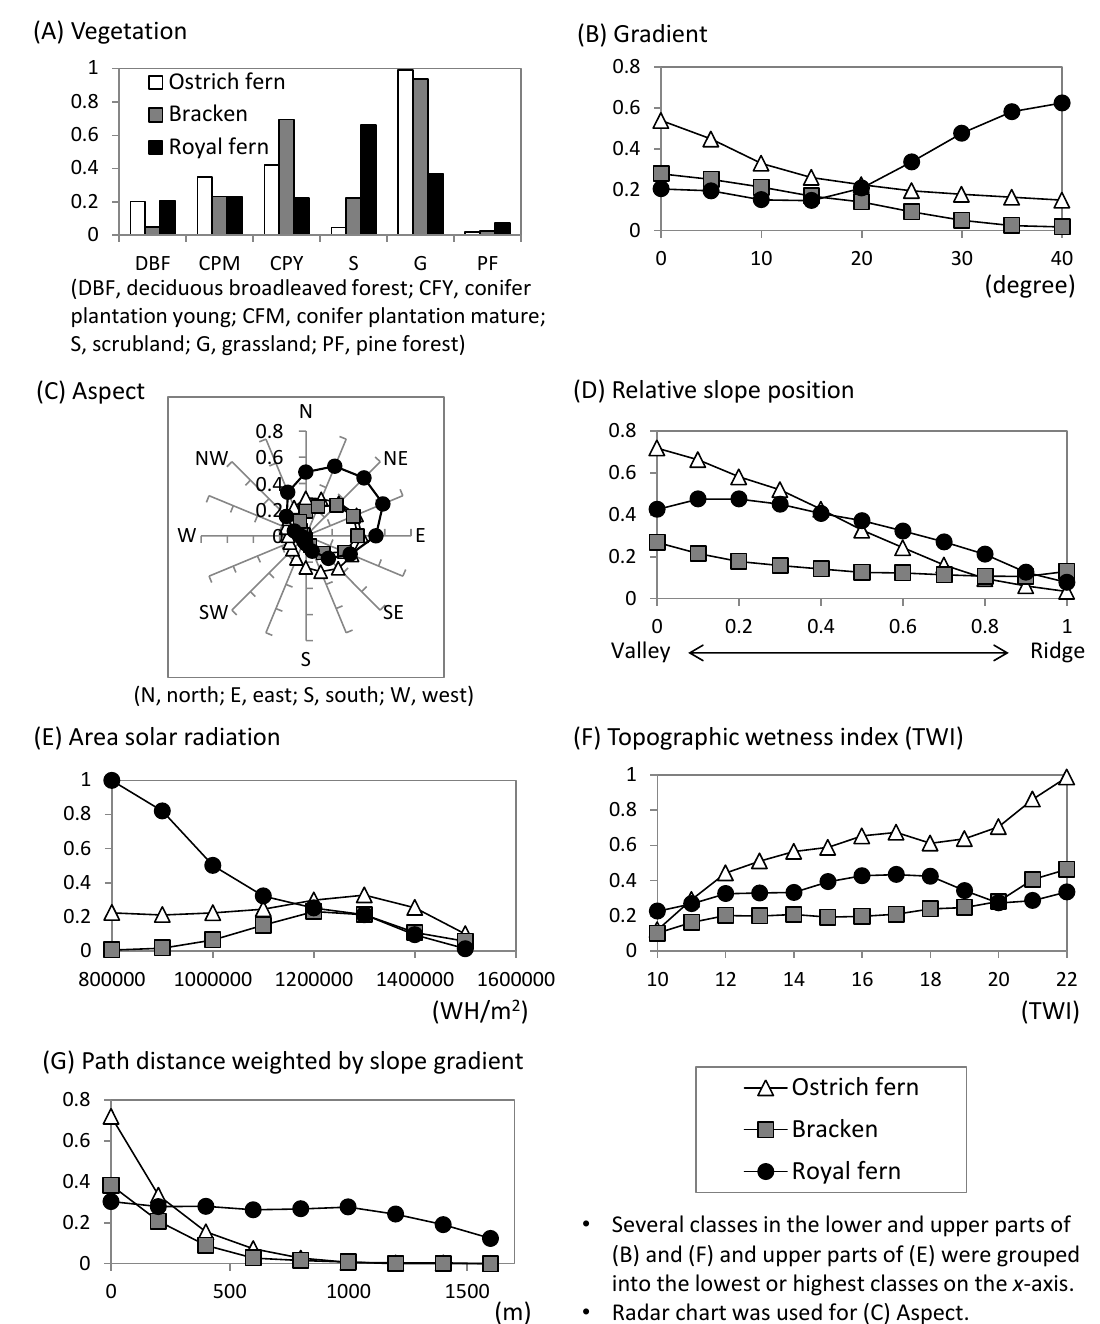
Figure 4. Relations between explanatory variables ( x -axis) and the area ratio of the estimated presence pixels in each class ( y -axis). Explanatory variables are ( A ) vegetation; ( B ) gradient, ( C ) aspect, ( D ) relative slope position, ( E ) area solar radiation, ( F ) topographic wetness index (TWI), and ( G ) path distance weighted by slope